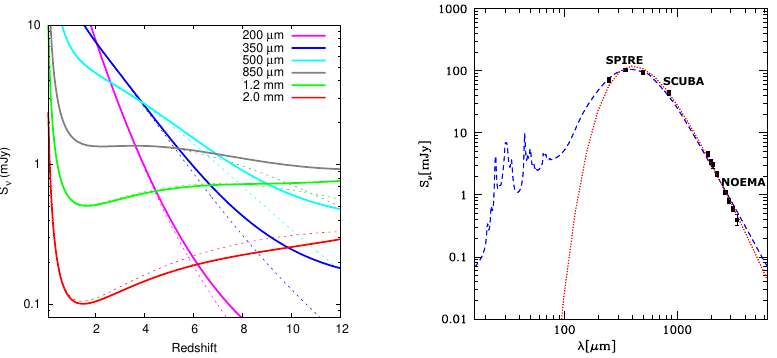
and a dust (cid:30)